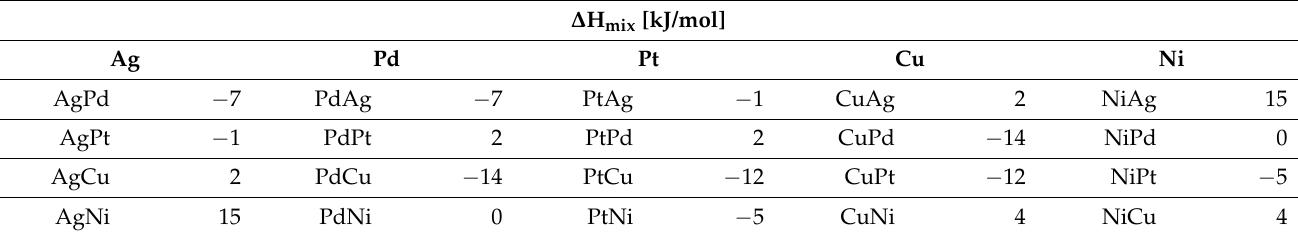
Table 4. Mixing enthalpies of binary systems [35].